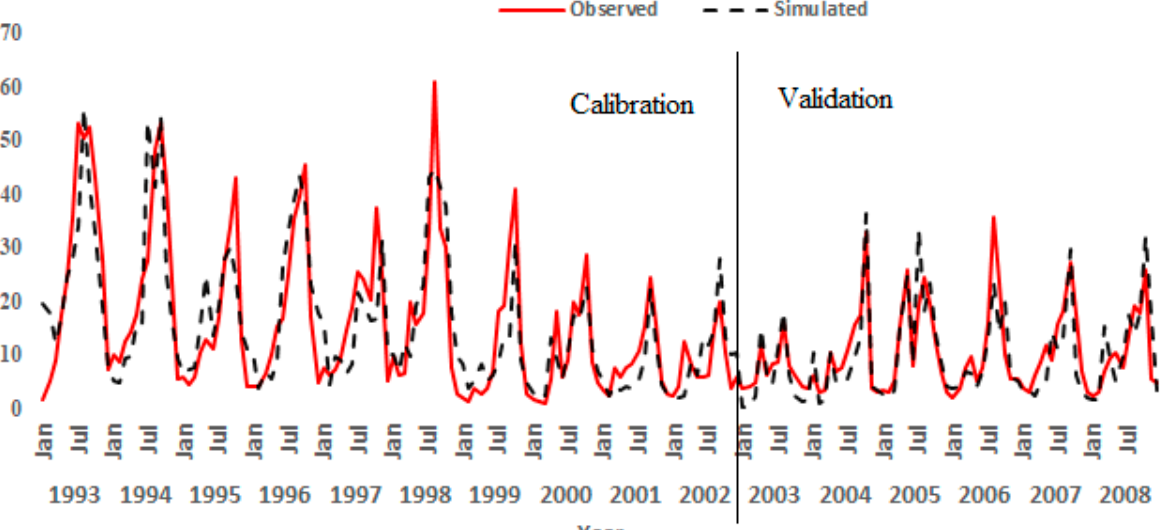
Figure 4. Monthly observed- and simulated-stream-flow for calibration and validation period. Crop parameters were also calibrated manually, using annual average-yield data collected from different districts in the watershed. The fraction of leaf-area index, harvest index, and parameters related to growing season-length had more influence on yield and crop evapotranspiration during simulation. The identified crop parameters and their values before and after calibration are presented in Table 3. Table 3. Adjusted crop-parameters .